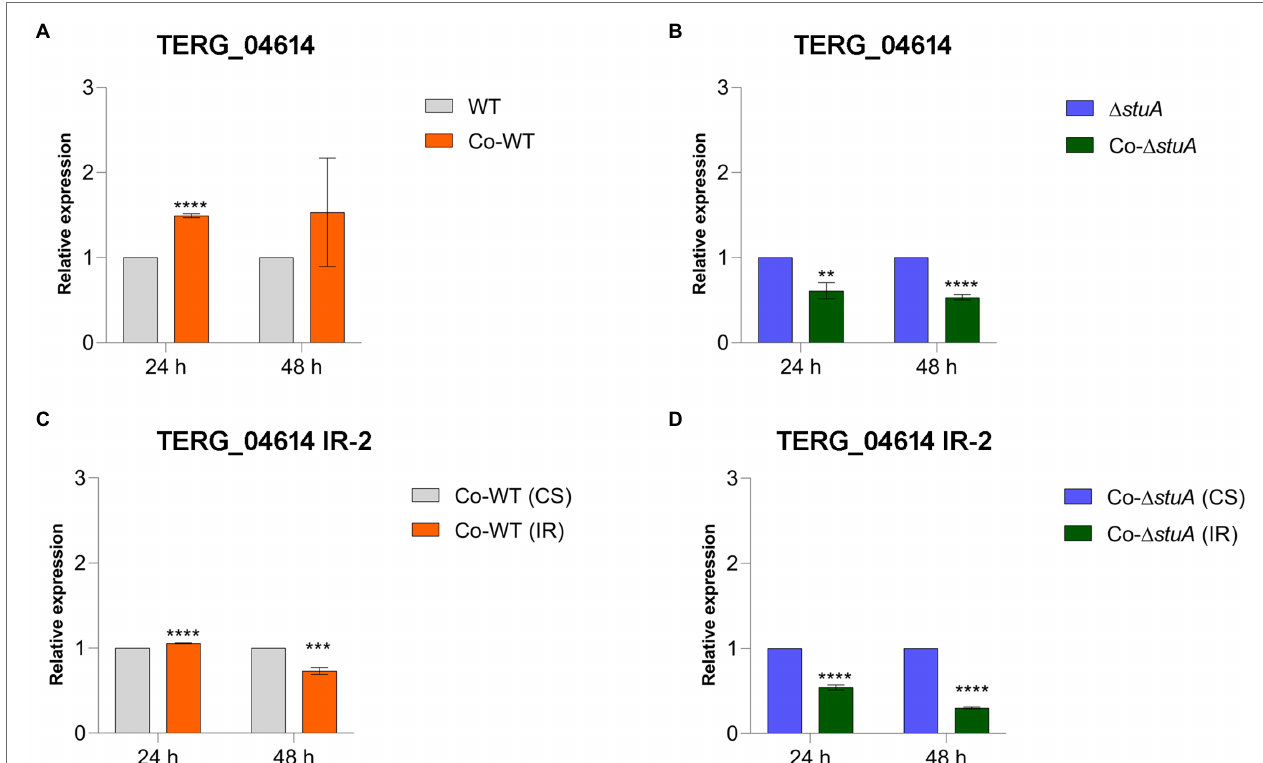
FIGURE 5 | Relative expression of the CS isoform of TERG_04614 in co-culture with keratinocytes with (A) WT and (B) Δ stuA strain, taking the levels of the transcripts of the fungal cells as reference of normalizing condition. Relative expression of the IR isoform of TERG_04614 in co-culture with keratinocytes with (C) WT and (D) Δ stuA strain, taking the levels of CS transcripts for each strain as the reference of normalizing condition. Statistical analyses for transcript quantification experiments were carried out using unpaired t -tests, and statistical significance was determined by the Holm-Sidak method considering ** p < 0.01, *** p < 0.001, and **** p <